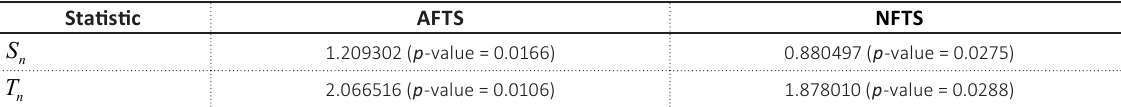
Table 2. Goodness-of-fit of the TFS-GARCH models